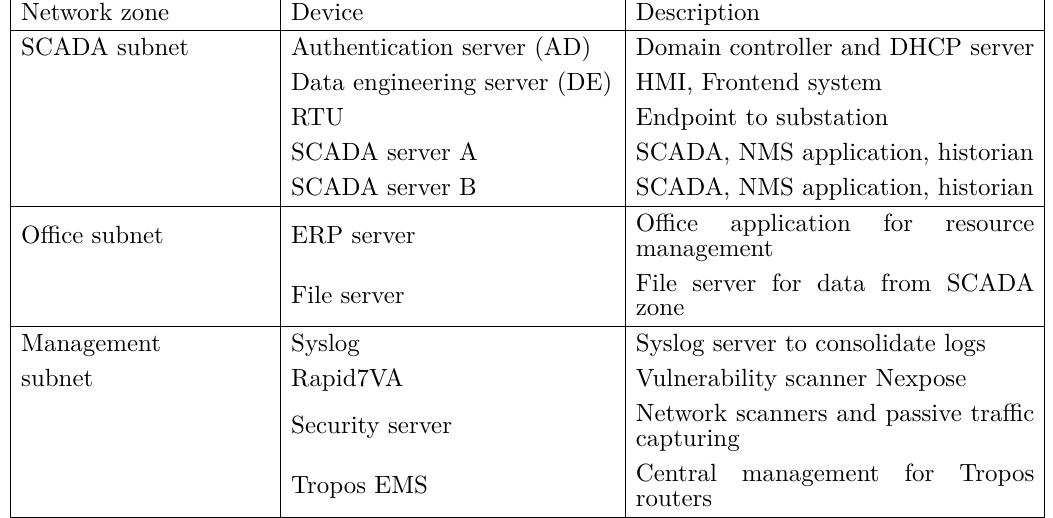
Figure 6. A small utility SCADA environment setup Table 4. Devices in the SCADA environment with short descriptions Network zone